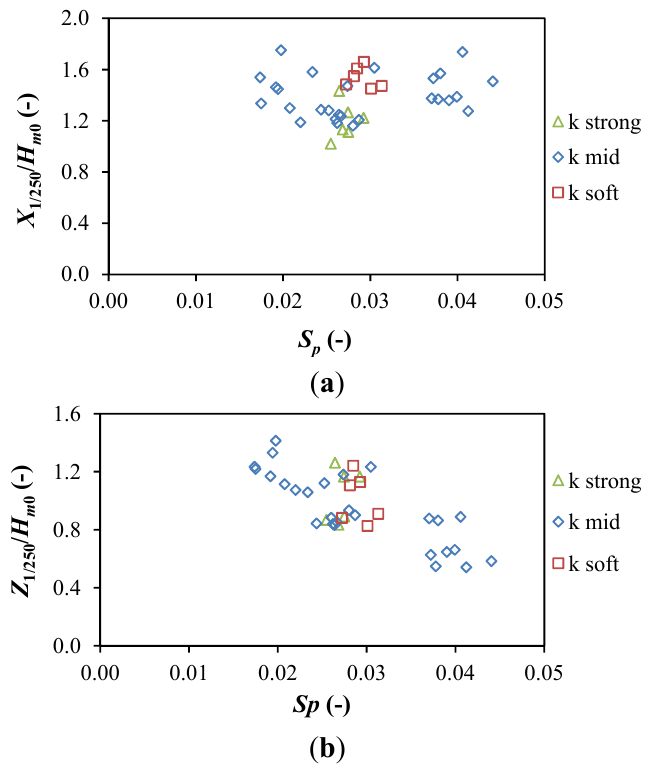
Figure 8. Extreme non-dimensional motions responses in ( a ) surge; ( b ) heave; and ( c )